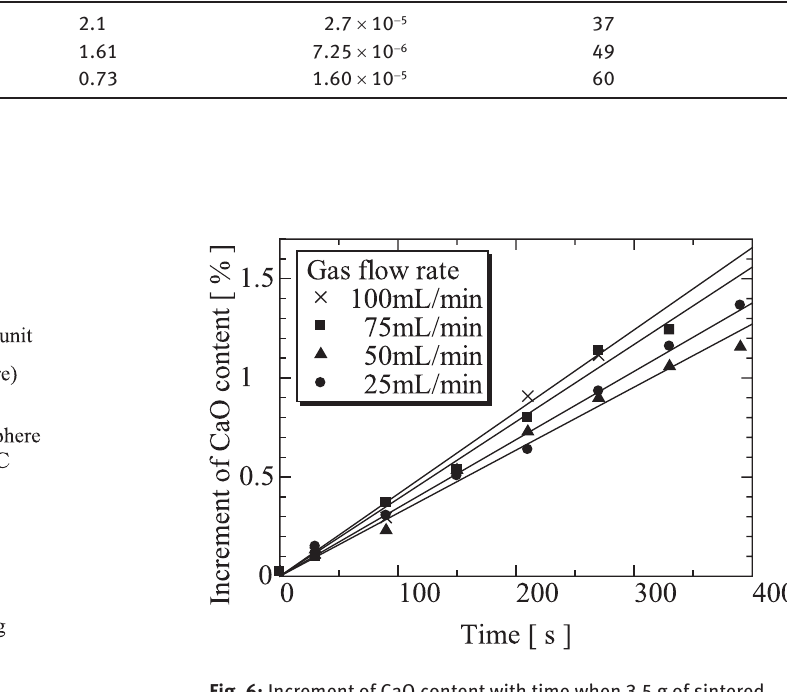
Fig. 6: Increment of CaO content with time when 3.5 g of sintered